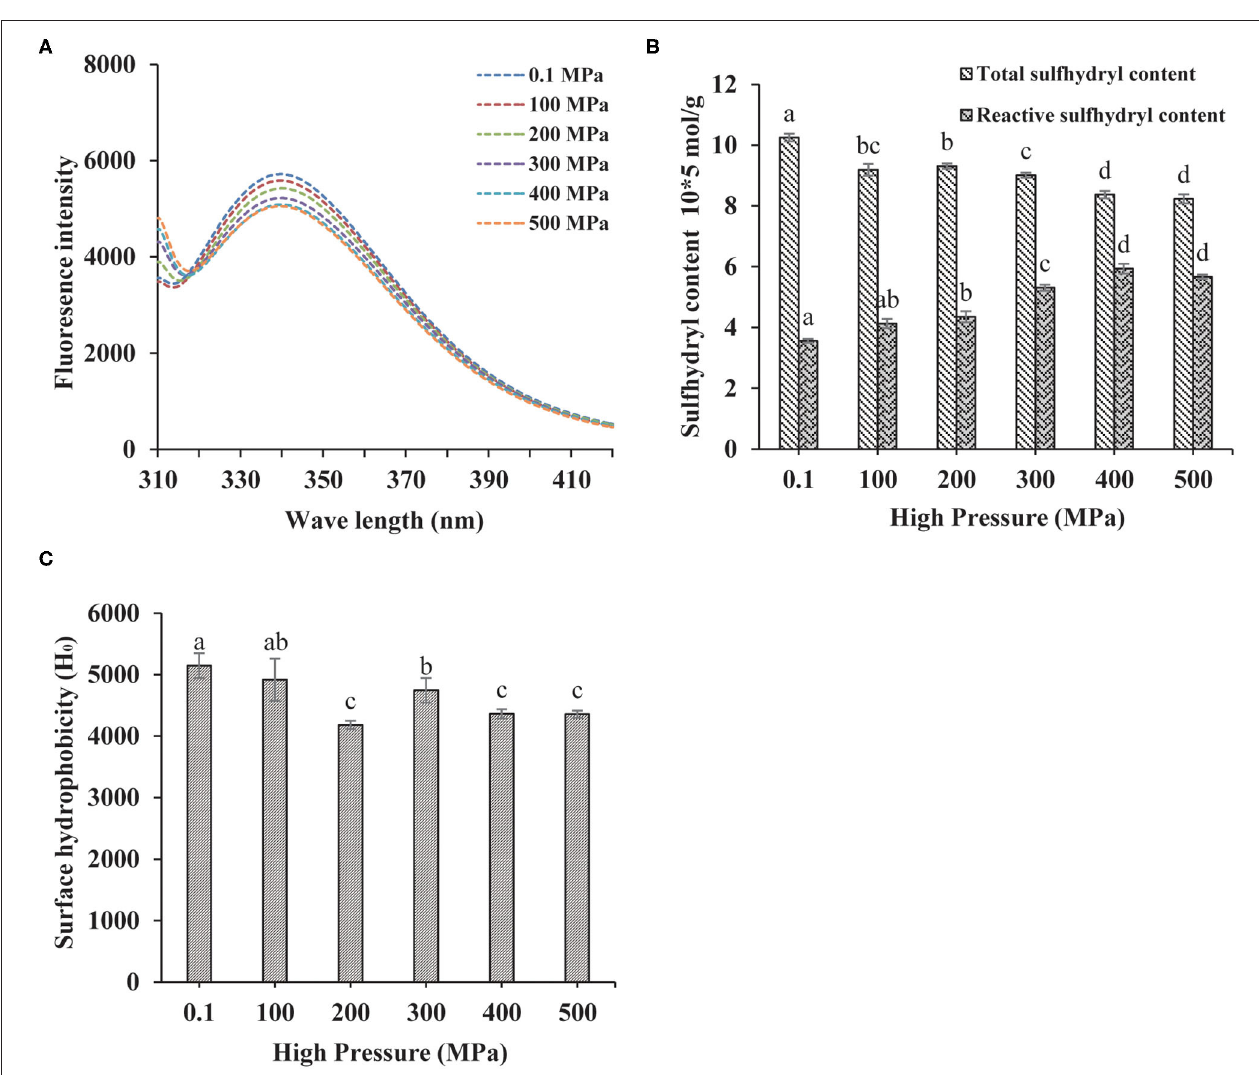
FIGURE 2 | Changes in the endogenous fluorescence (A) , sulfhydryl contents (B) , and surface hydrophobicity (C) of MP from the scallop mantle under the ultra-high pressure (UHP) treatment. interactions between hydrophobic ANS probes and proteins (28). of proteins. After the UHP treatment, the protein conformation structure became loose and destabilized due to the stretching Surface hydrophobicity got its minimum at 200 MPa. When the and unfolding of MP, which was detrimental to the hydrophobic pressure was higher than 300 MPa, the hydrophobic groups